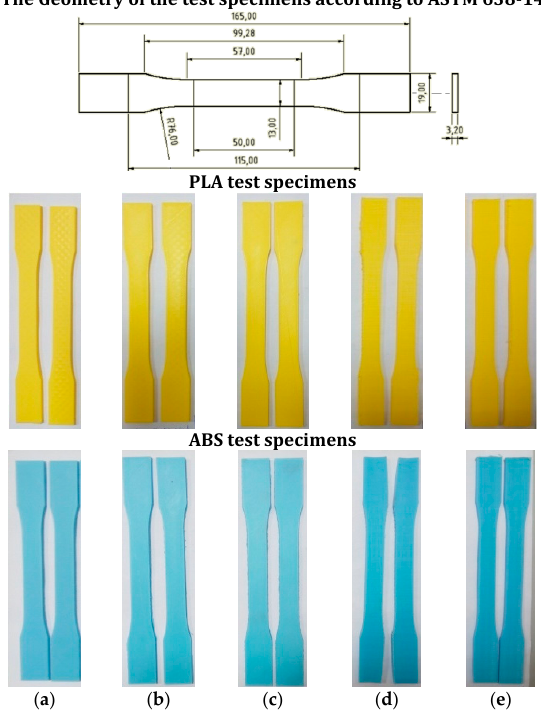
Figure 5. The test specimens manufactured using PLA and ABS. ( a ) Case 1; ( b ) Case 2; ( c ) Case 3; ( d ) Case 4; ( e ) Case 5.